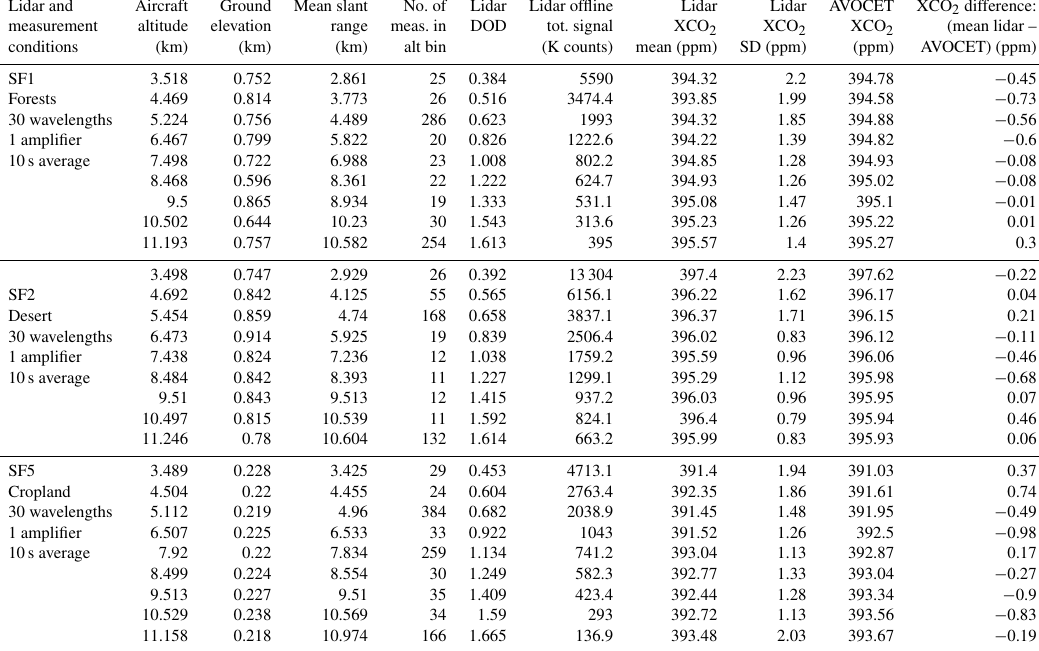
Table A1. Summary of results for three of the 2014 flights. Lidar and Aircraft Ground Mean slant